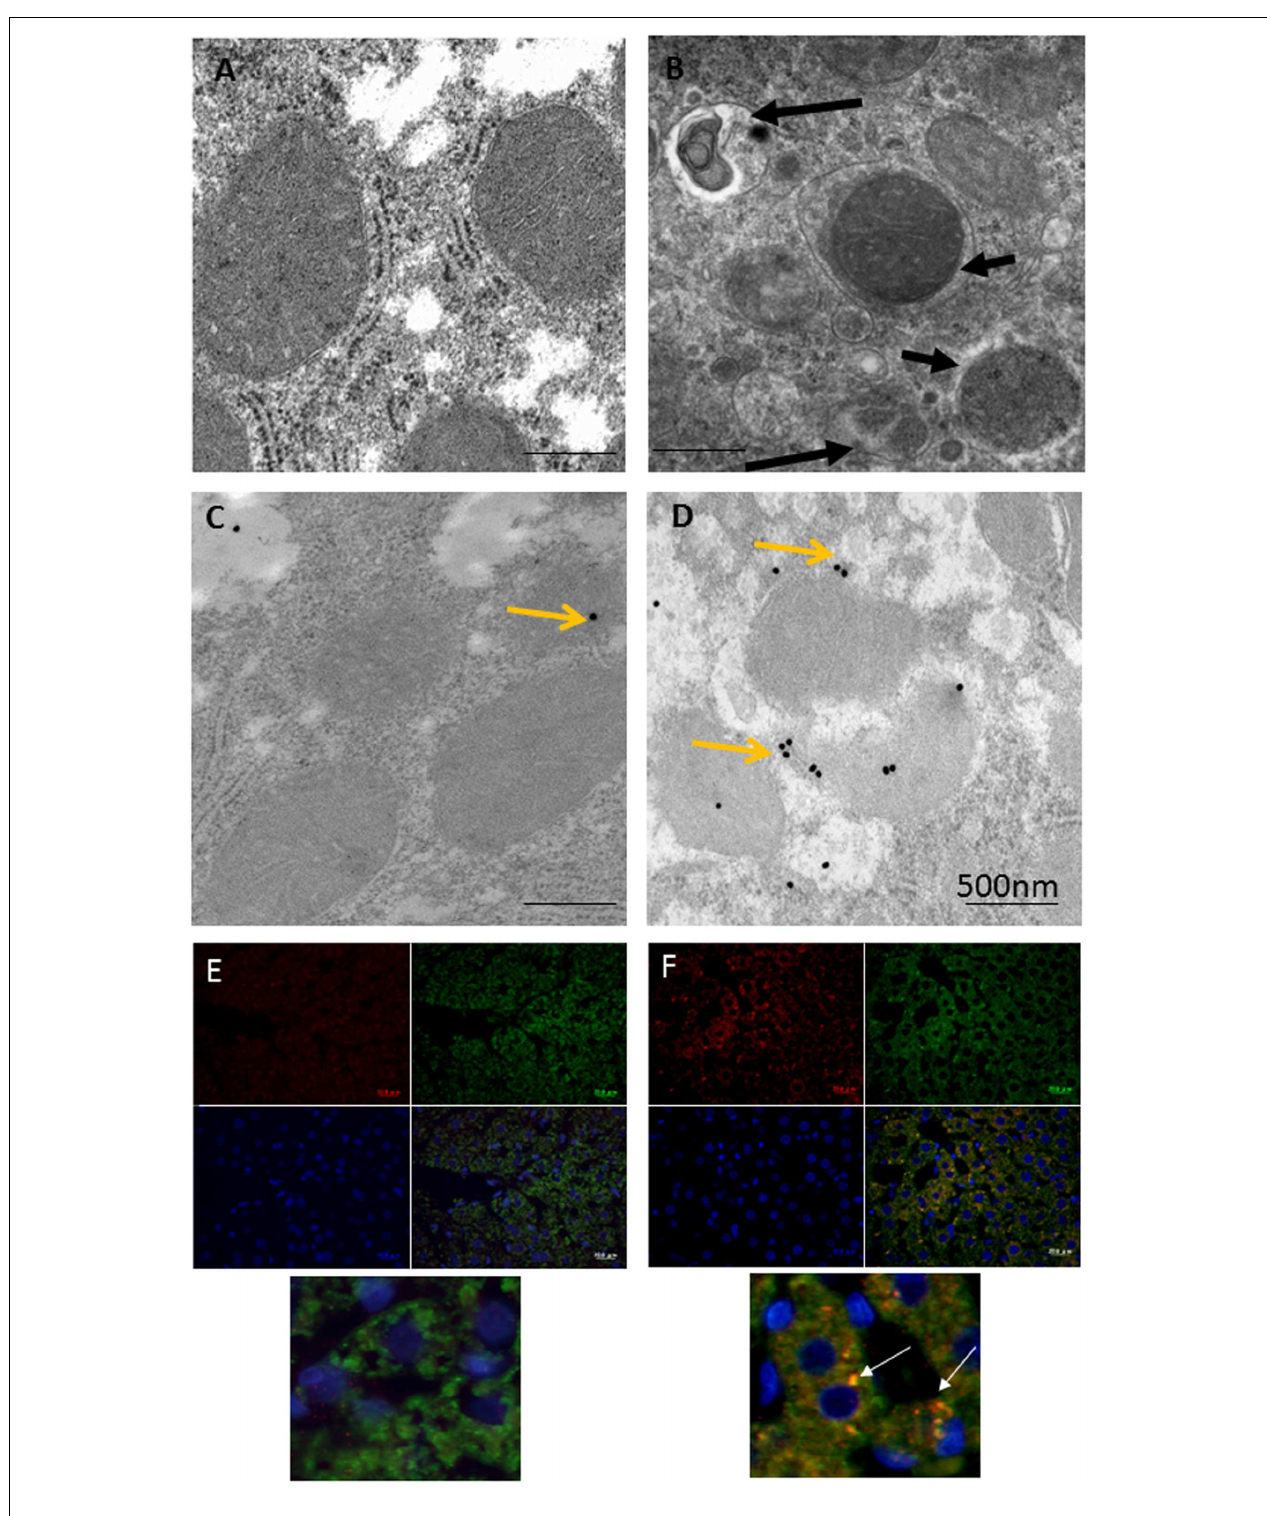
FIGURE 1 | Enhanced mitophagy in hepatocytes of ETRs. (A,B) TEM of control (A) and ETRs (B) . The short black arrows indicate mitophagosomes, while the long black arrows show mitophagolysosomes. (C,D) IEM of Parkin in control (C) and ETRs (D) . Yellow arrows indicate 25 nm Parkin immunogold particles. (E,F) Immunofluorescence double labeling of Parkin (Red) and cytochrome c (green) in control (E) and ETRs (F) . The white arrows show colocalization signals on merging (yellow) in magnified areas below. Note that DAPI (blue) is for nuclear counterstaining.